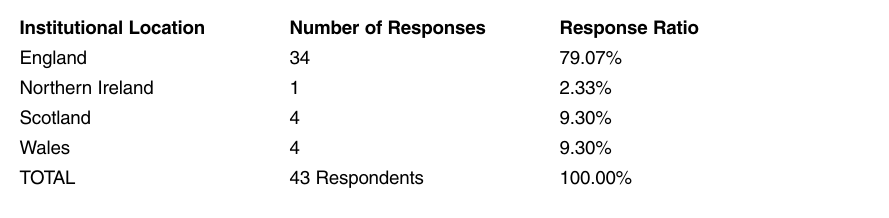
Table 1: Institutional locations of HEIs